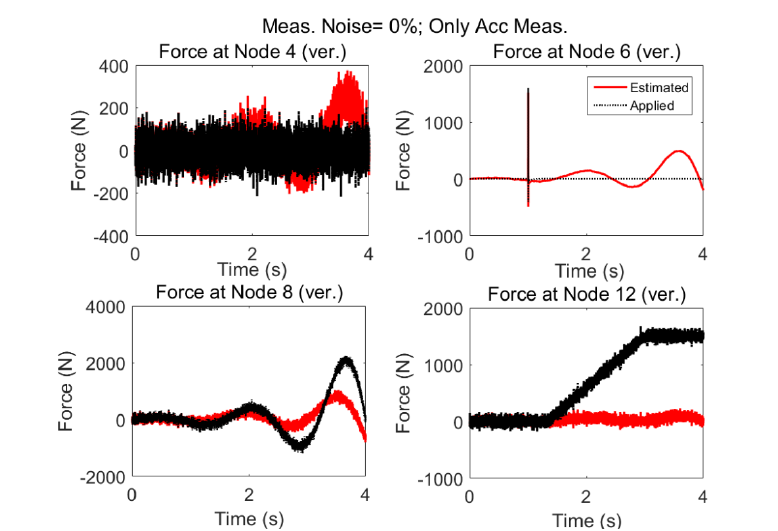
Figure 11. System is subjected simultaneously to four different forces where some of them have nonzero mean and low frequency and high amplitude. No error (modeling and measurement error) is added and excitation is estimated by AKF only using the accelerations. Even without added uncertainties relying solely on acceleration will fail to estimate the inputs.